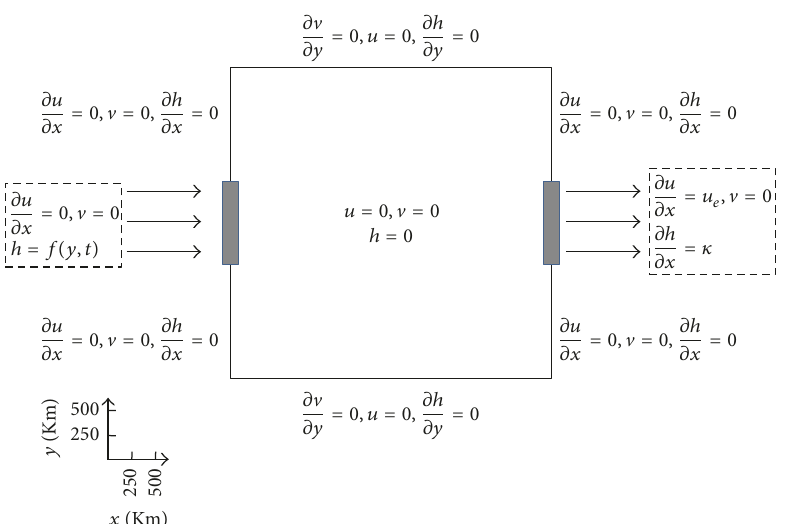
Figure 2: Initial and boundary conditions of hydrodynamic model in opened-closed reservoir.